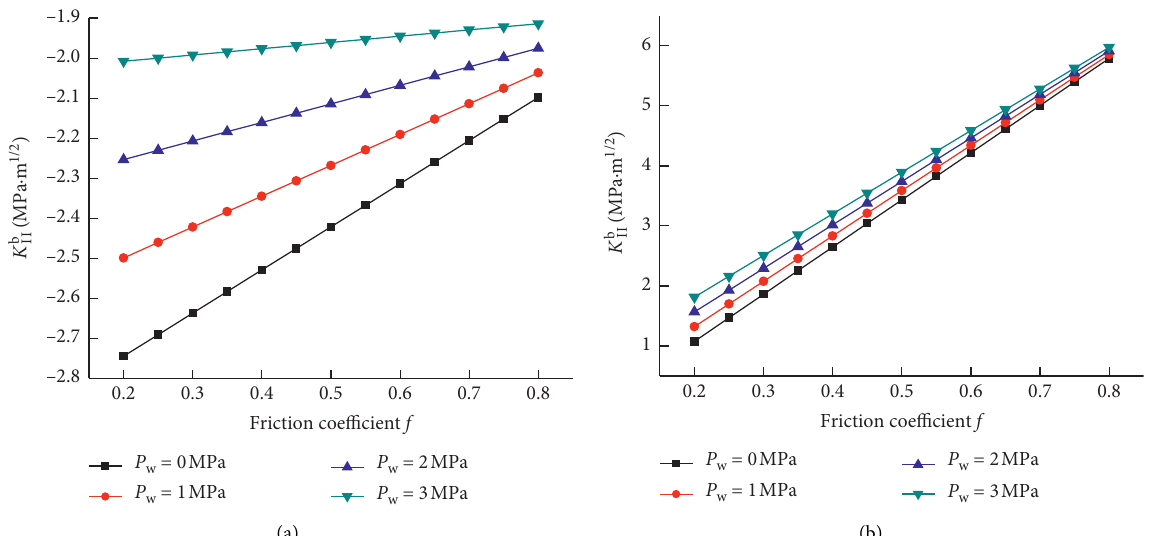
Figure 9: Relationship between mode II stress intensity factor and friction coefficient. (a) σ